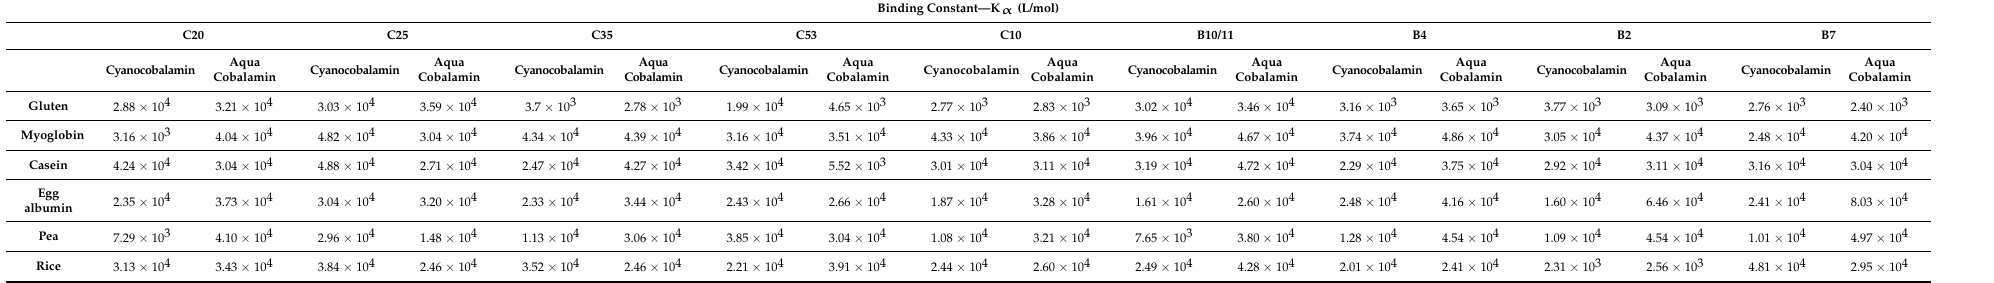
Table 1. Binding constants (K α ) of different carbon atoms of vitamin B12—protein interaction